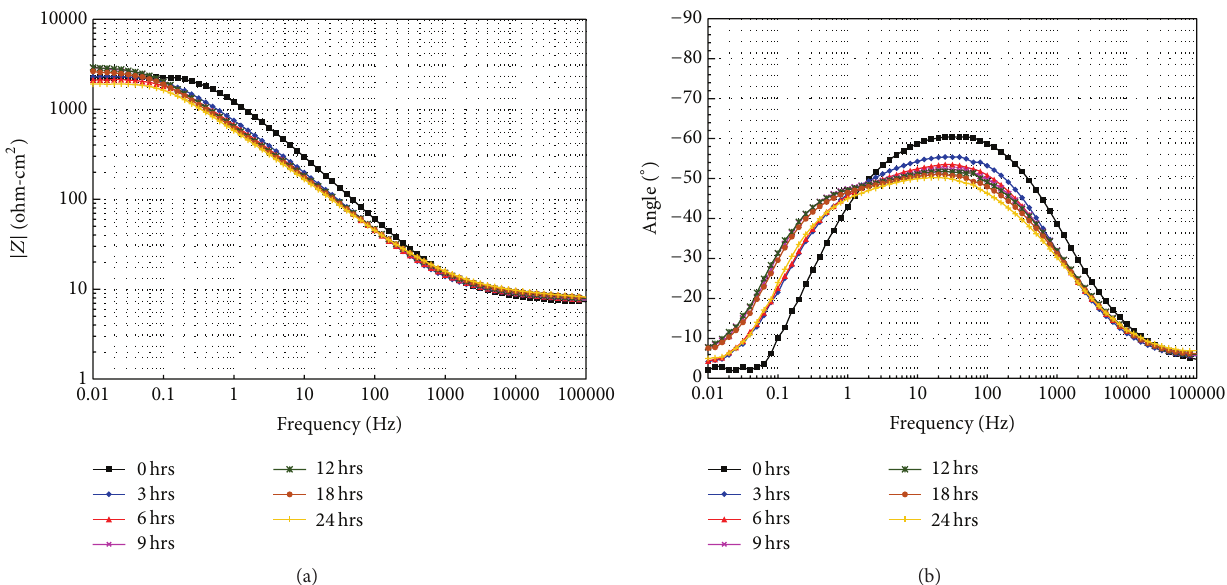
Figure 10: Bode plots for 30Nd6Pr magnet tested in 3.5% NaCl solution at 25 ∘ C for 24 hours.